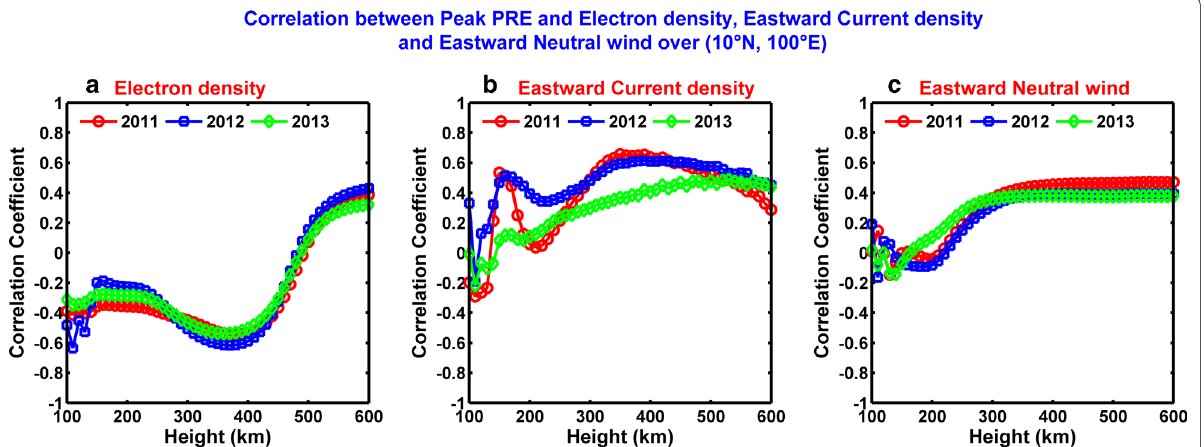
Fig. 3 Correlation between the day-to-day variation of the peak PRE and electron density, eastward current density and eastward neutral wind during 2011 (red line), 2012 (blue line) and 2013 (green line) over (10° N, 100° E; GAIA co-ordinates) near Chumphon in